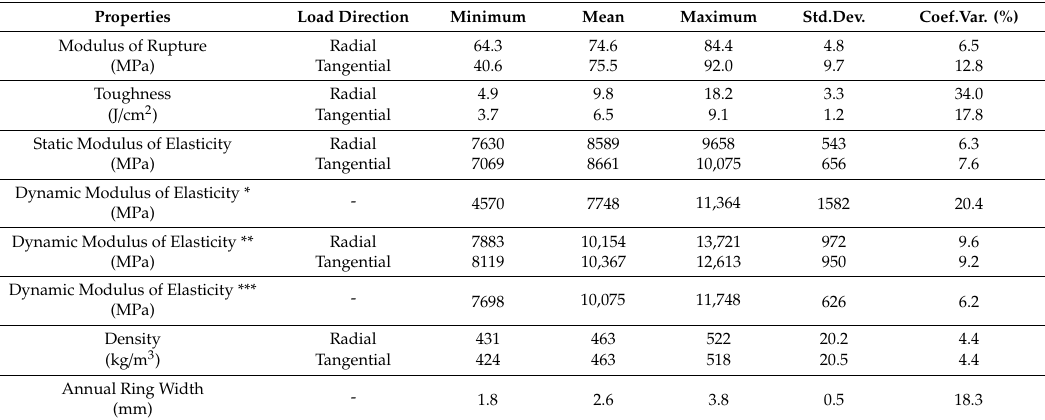
Table 1. Basic Statistical Analyses of the Properties for Spruce